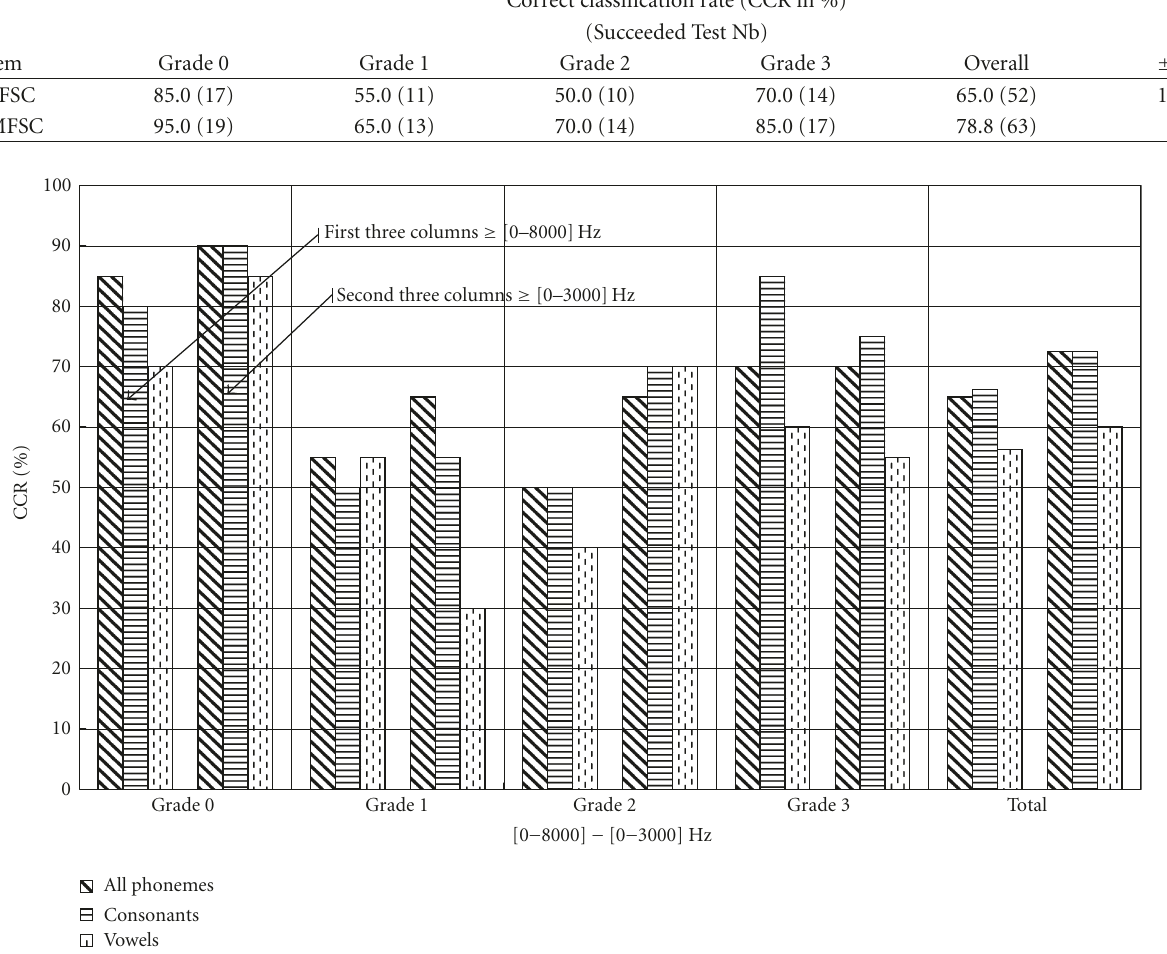
Figure 4: Performance per grade in terms of correct classification rate (CCR %) considering “All phonemes”, consonant and vowel classes, for the 0–8000 Hz (each first set of three columns) and 0–3000 Hz (each second set of three columns) frequency